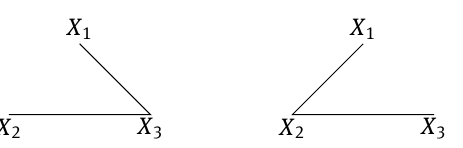
Figure 8: MSTs constructed from the different dependence measures using correlation distance as weight function. Left: ρ S , τ . Right: Cor